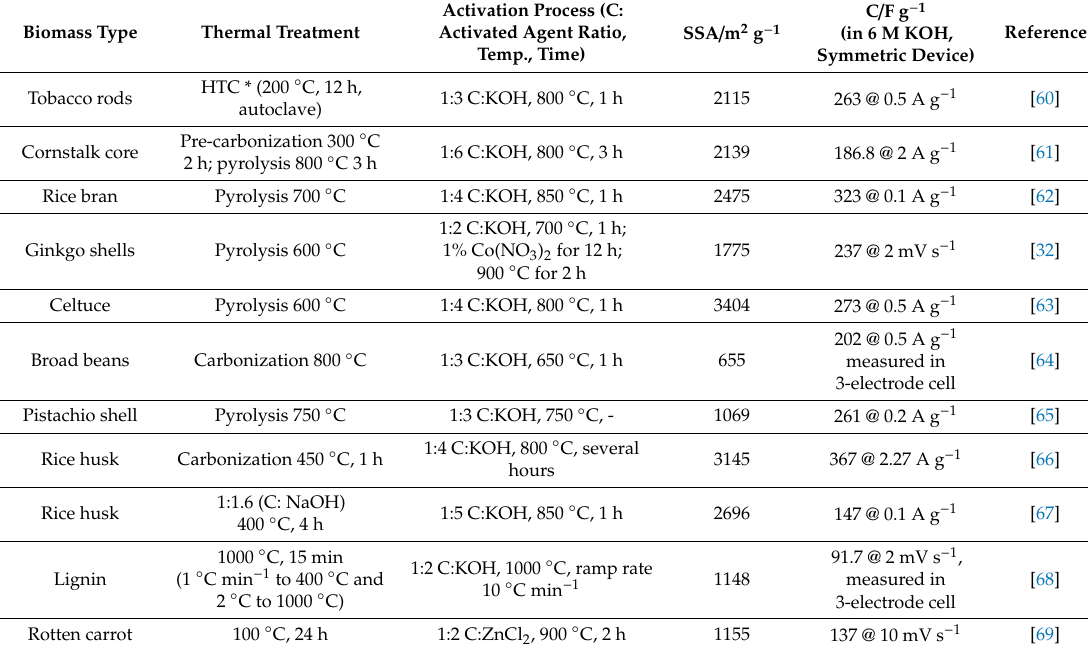
Table 3. Comparison of specific surface area (SSA) and capacitance values for activated carbons derived from various biomass types, treated with different pyrolysis and activation conditions.